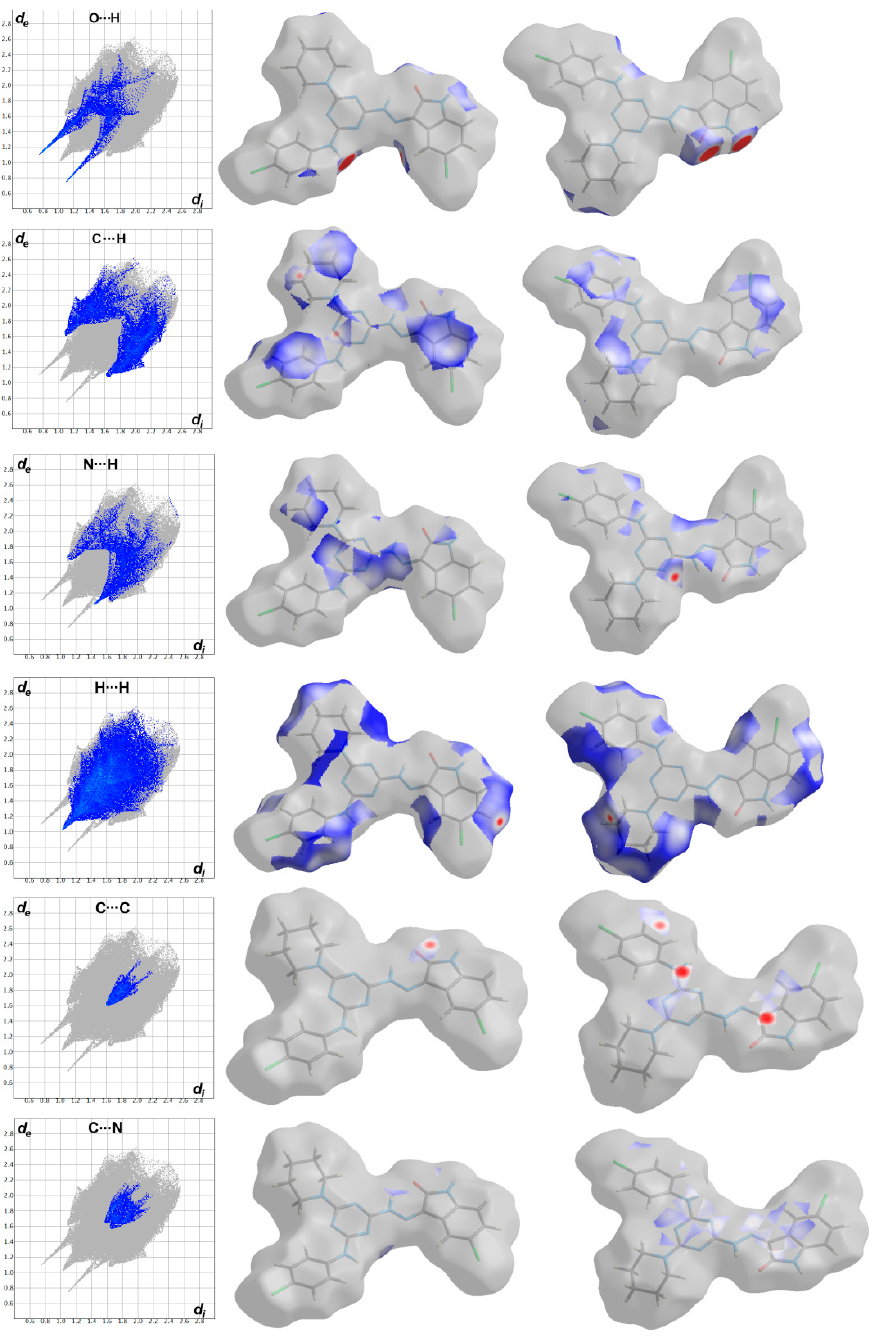
Figure 5. The fingerprint plots and d norm maps for the important contacts in the target molecule in the crystal structure of 6c .